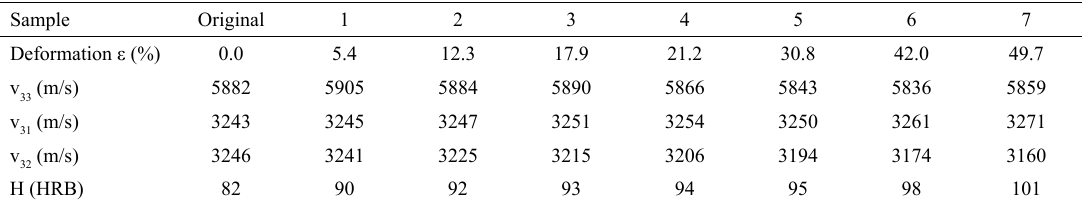
Table 2. Averages of the wave velocities and hardness in the rolled